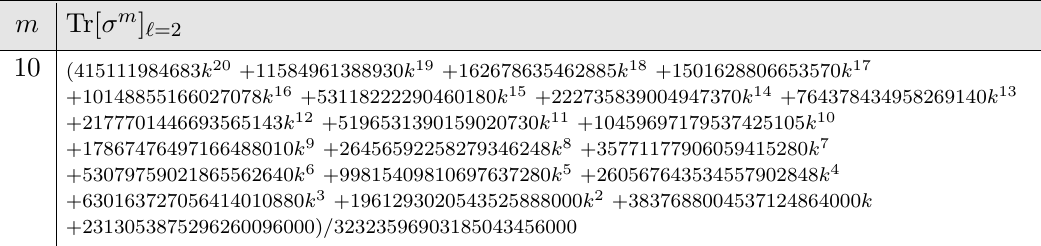
Table 6. The values of Tr [ σ m ] as a function of k for T 2 , 6 torus link. The subscript ‘ indicates that the polynomial is valid for k ≡ ‘ ( mod 3)